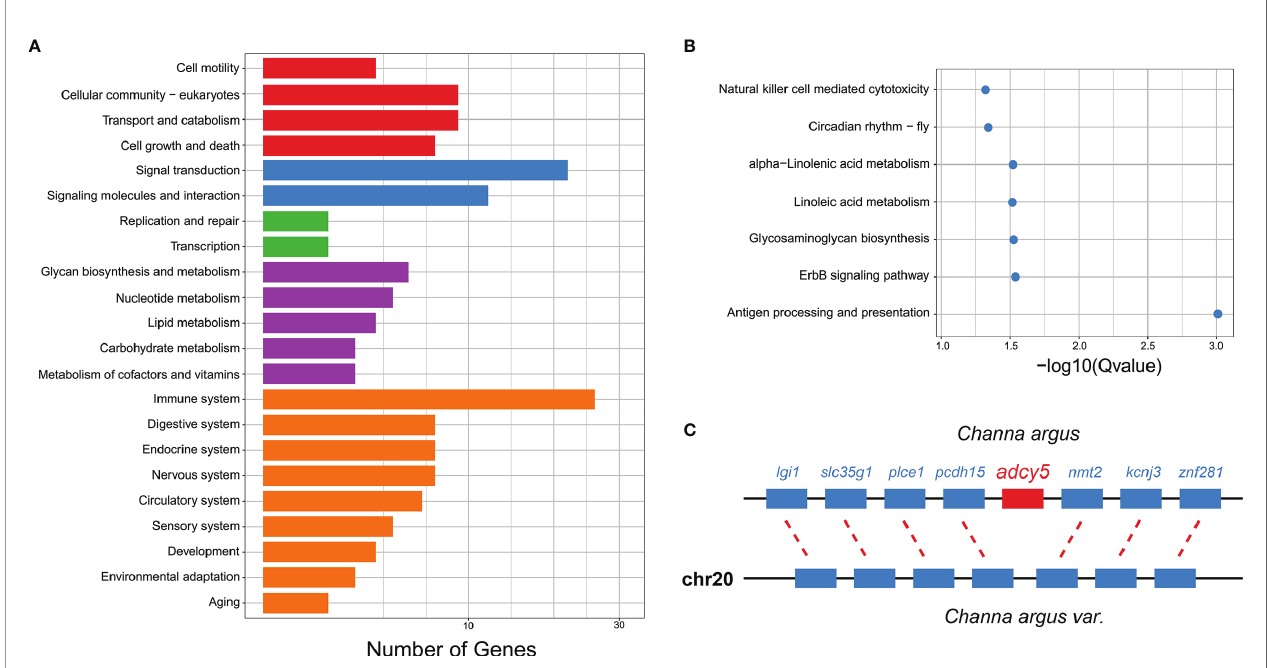
FIGURE 5 | The C. argus var. and C. argus genome-speci fi c gene identi fi cation and functional analysis. (A) The functional categories of KEGG annotations for candidate speci fi c genes of C. argus . (B) The enrichment on KEGG annotation for candidate speci fi c genes of C . argus . (C) The colinearity of neighboring genes to identify the absence of adcy5 in the C . argus var.